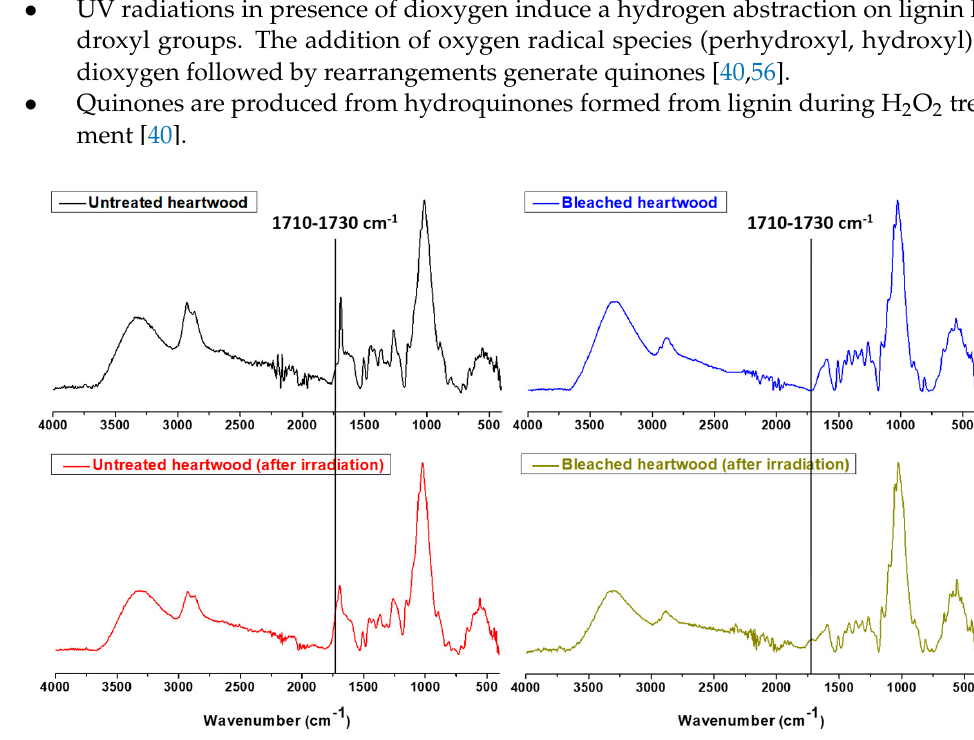
Figure 10. ATR traces of maritime pine heartwood (untreated and bleached) before and after UV irradiation ageing.